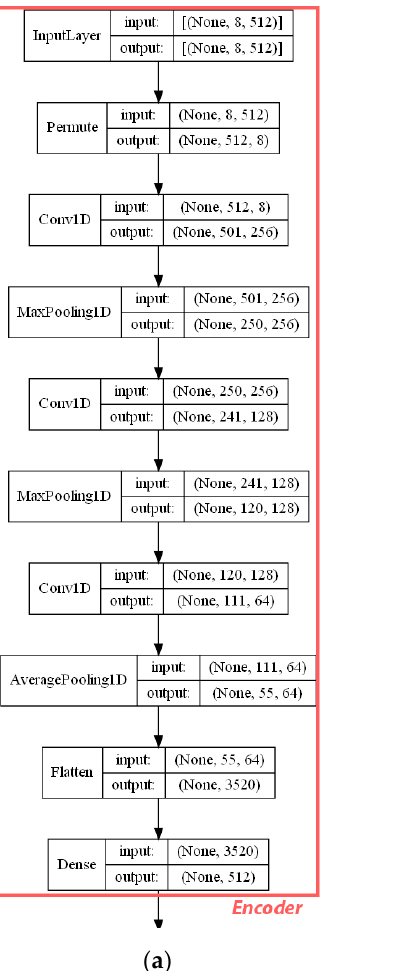
Figure A2. The 1D CNN auto-encoder composed of encoder ( a ) and decoder ( b ).